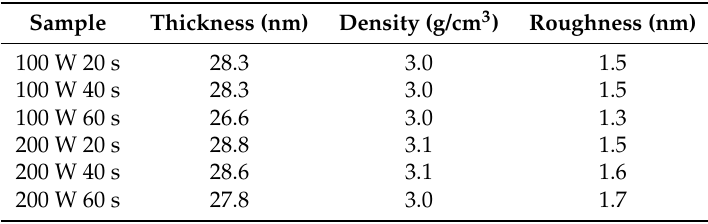
Table 1. Thickness, density and roughness from matching of XRR data of the ALA treated films on Si<100>